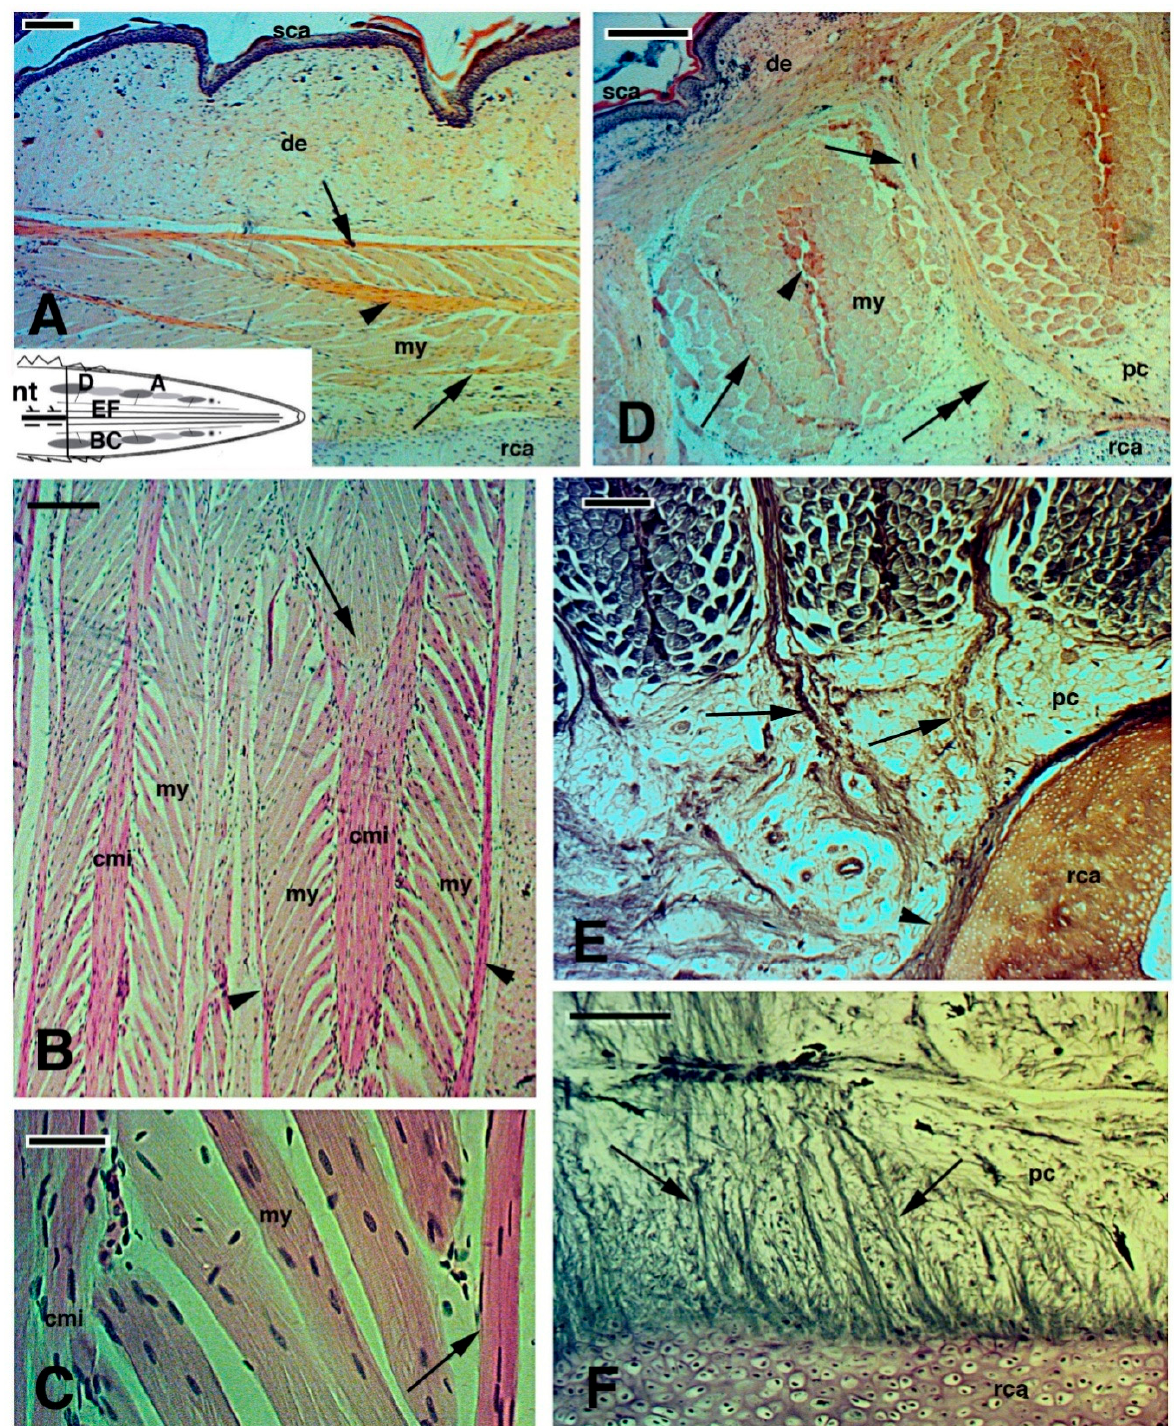
Figure 7. Images derived from different areas of old regenerated tails of unknown age ( A – D ), Haematoxylin-Eosin stain; ( E , F ), Palmgren stain). ( A ), detail of regenerated muscles with outer myoseptum (arrows) and inner myoseptum (arrowhead). Bar, 50 µ m. The schematic drawing shows the positions of the following figures. ( B ), detail to show the leaf-like organization of regenerated muscles. The arrow shows a muscle cone of a myomer that is inserted in the following myomer through the central myoseptum. Bar, 50 µ m. ( C ), detail of multinucleated muscle fibres attached to the central and lateral (arrow) myosepta. Bar, 10 µ m. ( D ), cross sectioned muscle bundles close to the tail stump showing the central myoseptum (arrowhead), the